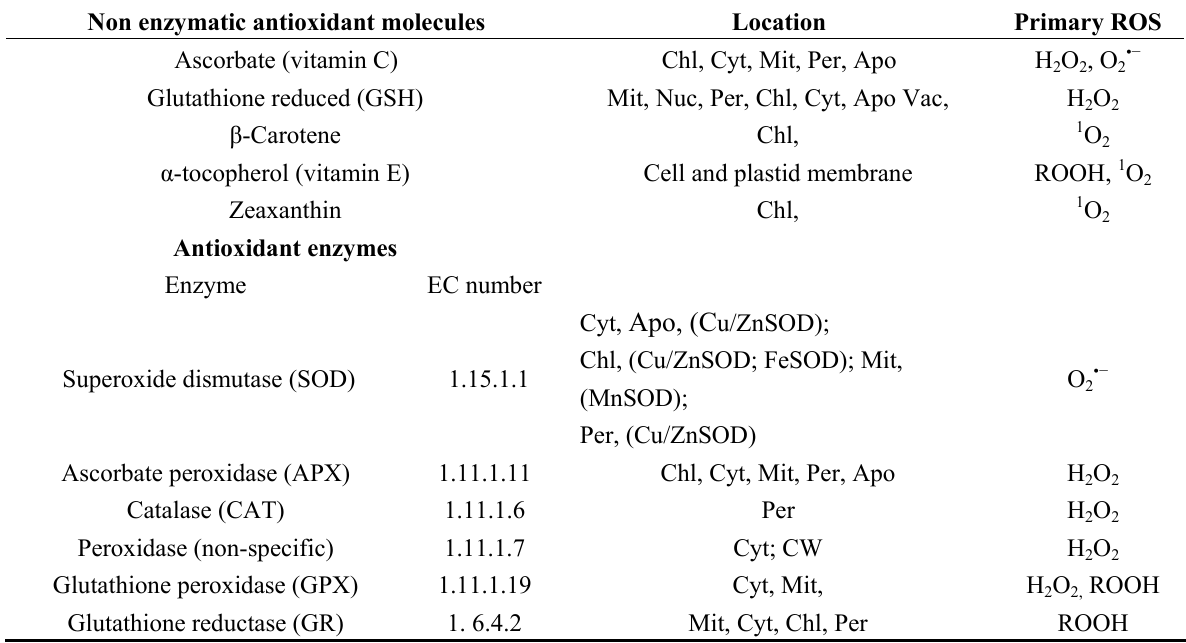
Table 1. Some natural antioxidants. Adapted from Scandalios